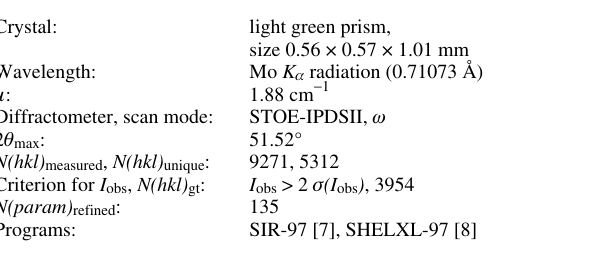
Table 1. Data collection and handling.